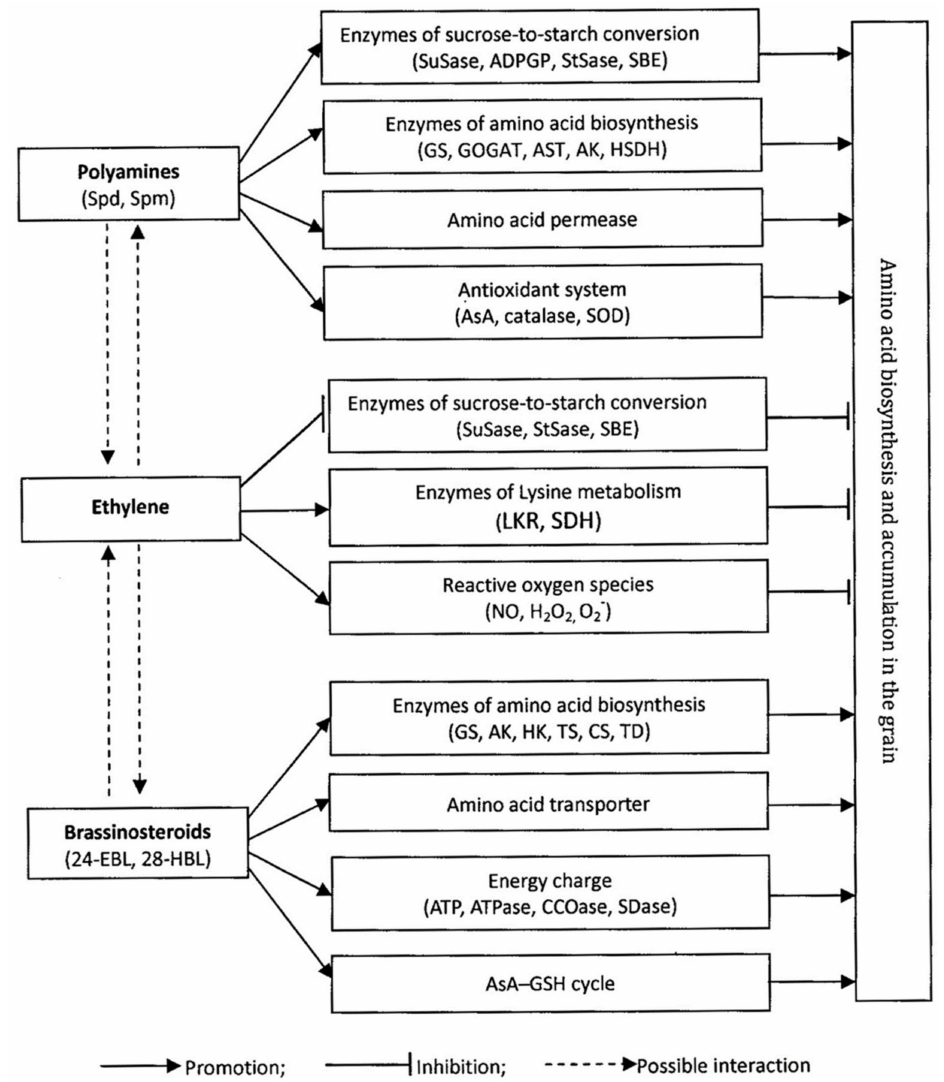
Figure 4. Schematic diagram of polyamines, ethylene, and brassinosteoids in mediating the biosyn- thesis of amino acids in the grain of rice. Spd, spermidine; Spm, spermine; 24-EBL, 24-epibrassinolide; 28-HBL, 28-homobrassinolide; SuSase, sucrose synthase; ADPGP, ADP glucose pyrophosphorylase; StSase, starch synthase; SBE, starch branching enzyme; GS, glutamine synthetase; GOGAT, glutamate synthase; AST, aspartate transaminase; AK, aspartate kinase; HSDH, homoserine dehydrogenase; AsA, ascorbic acid; SOD, superoxide dismutase; LKR, lysine α -ketoglutarate reductase; SDH, saccha- ropine dehydrogenase. HK, homoserine kinase; TS, threonine synthase; CS, cysthationine synthase; TD, threonine dehydratase; ATPase, adenosine triphosphatase; CCOase, cytochrome C oxidase; SDase, succinate dehydrogenase; AsA-GSH, ascorbate-glutathione. This diagram is